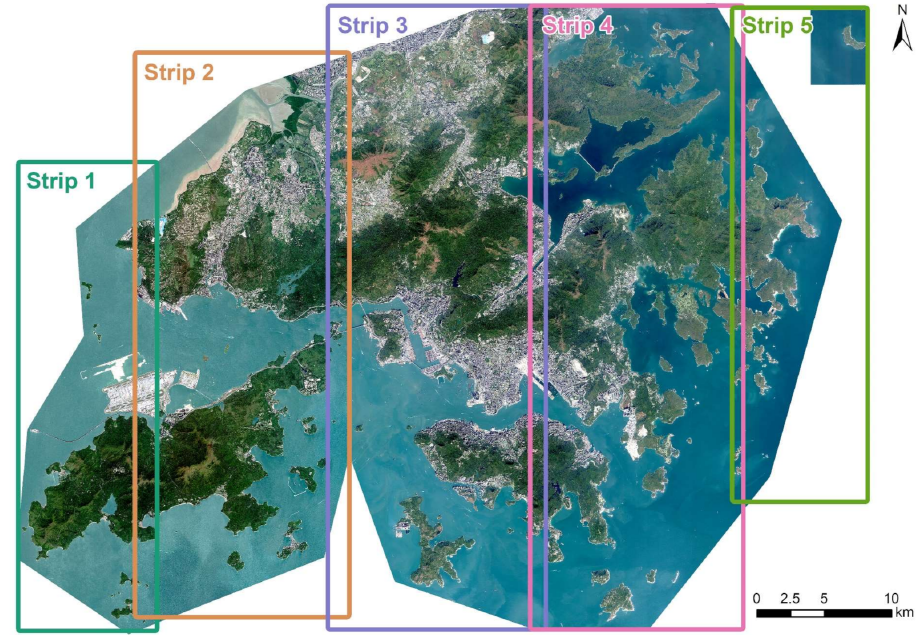
Figure 2. Mosaic of the satellite image consisted of five strips of WorldView-2 and -3 images used in this